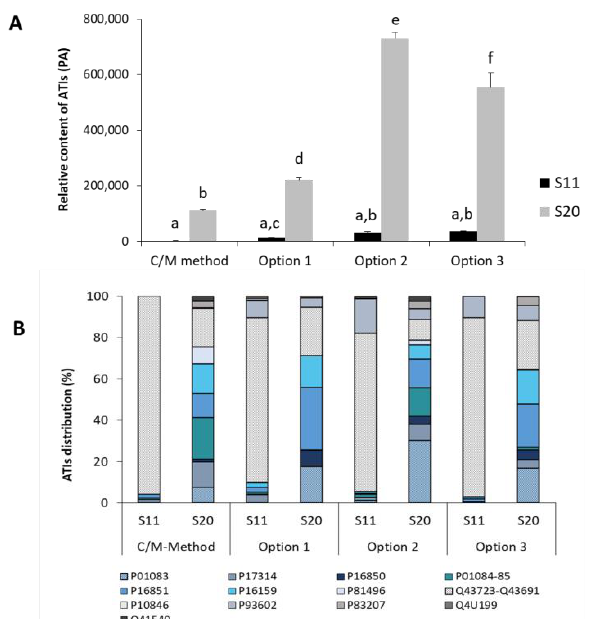
Figure 7. Relative ATI content ( A ) and ATI distribution ( B ) of wheat samples S11 and S20 from Turkey. The extraction was carried out using the C/M method and option 1–3 Ambi/urea method. Different letters mark significant difference ( p < 0.05, ANOVA).